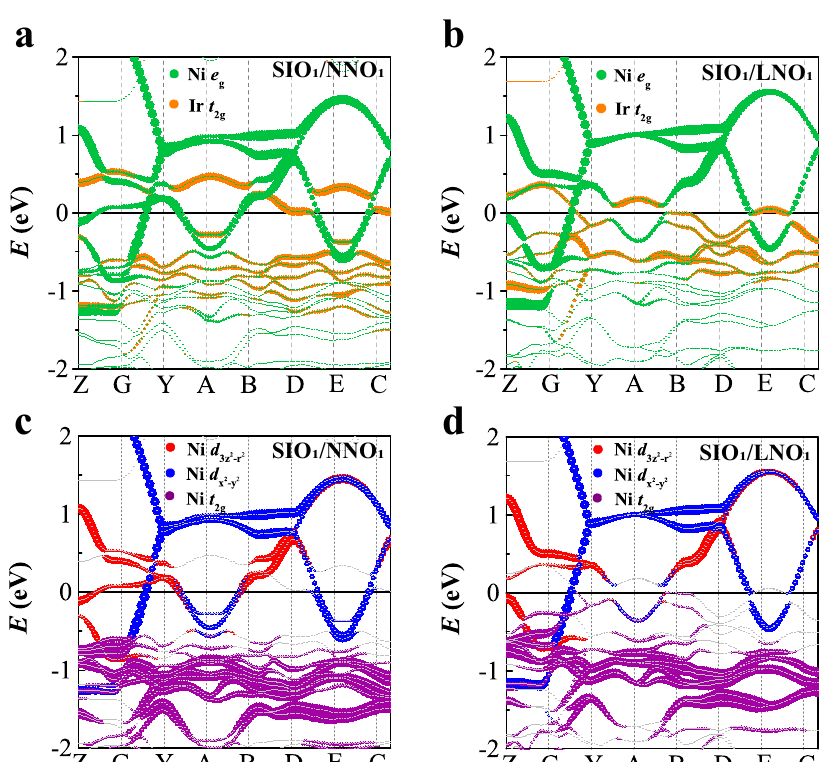
Fig. 4 Band structures and densities of states. Projected band structure of a (SrIrO 3 ) 1 /(NdNiO 3 ) 1 (abbreviated as SIO 1 /NNO 1 ), b (SrIrO 3 ) 1 /(LaNiO 3 ) 1 (abbreviated as SIO 1 /LNO 1 ) superlattices with Ni e g orbitals and Ir t 2g orbitals are shown in green and orange. Projected band structure of c SIO 1 /NNO 1 , d SIO 1 /LNO 1 superlattices with d 3z 2 (cid:1) r 2 , d x 2 (cid:1) y 2 , t 2g of Ni 3 d orbitals are shown in red, blue and purple, respectively. The fractional coordinate of Z, G, Y, A, B, D, E and C is (0,0,0.5), (0,0,0), (0,0.5,0), (0.5,0.5,0), (0.5,0,0), (0.5,0,0.5), (0.5,0.5,0.5), (0,0.5,0.5), to those in SIO 1 /NNO 1 . There are more empty states in the